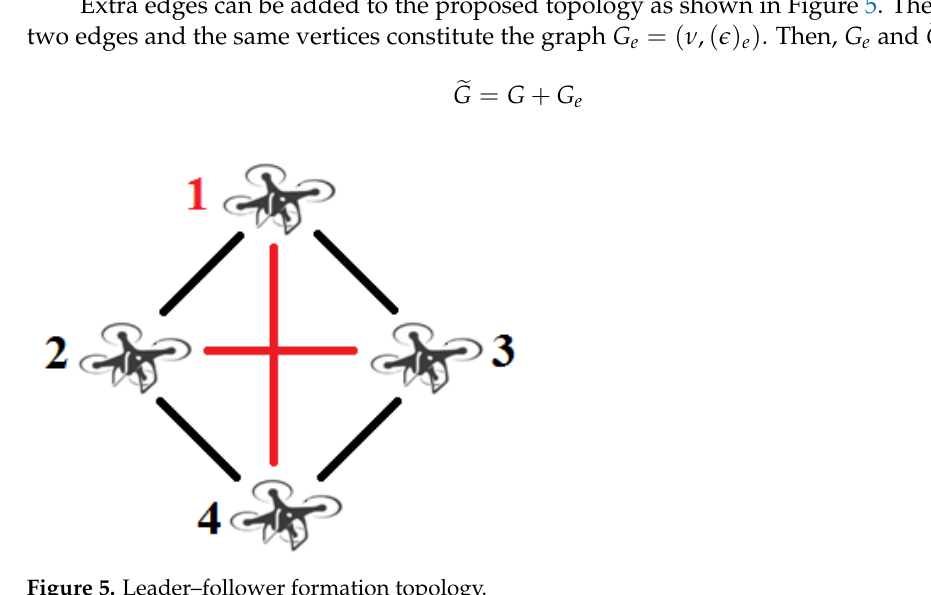
Figure 5. Leader–follower formation